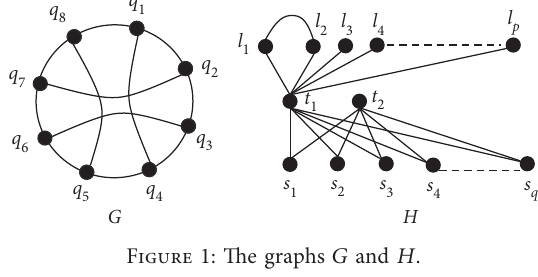
Figure 1: The graphs G and H , l , . . . , l , s , s , . . . , s 􏽮 􏽯 is a 1ser-set p q 1 2 2 3